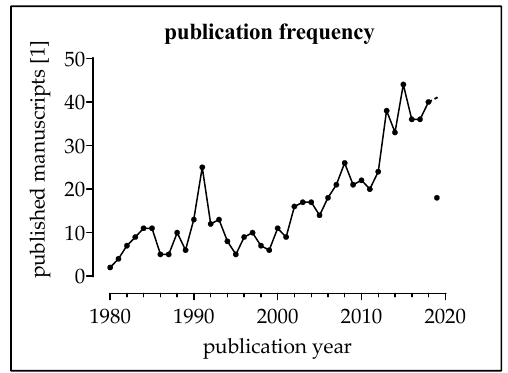
Figure 8. Number of publications published per year with the used (Table 2) search terms.